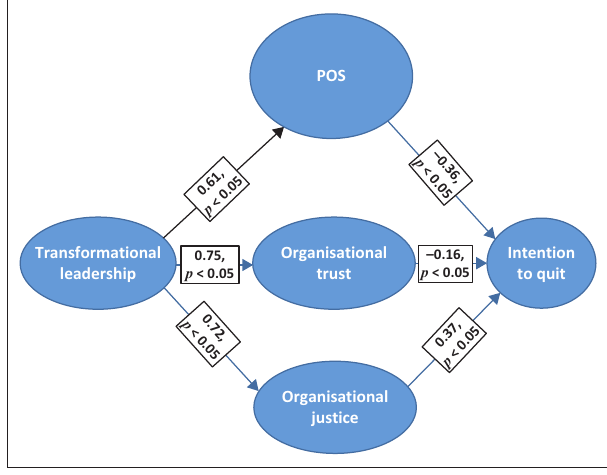
FIG URE 2: Empirical results of the relationships among transformational leadership, perceived organisational support, organisational justice, organisational trust and intention to